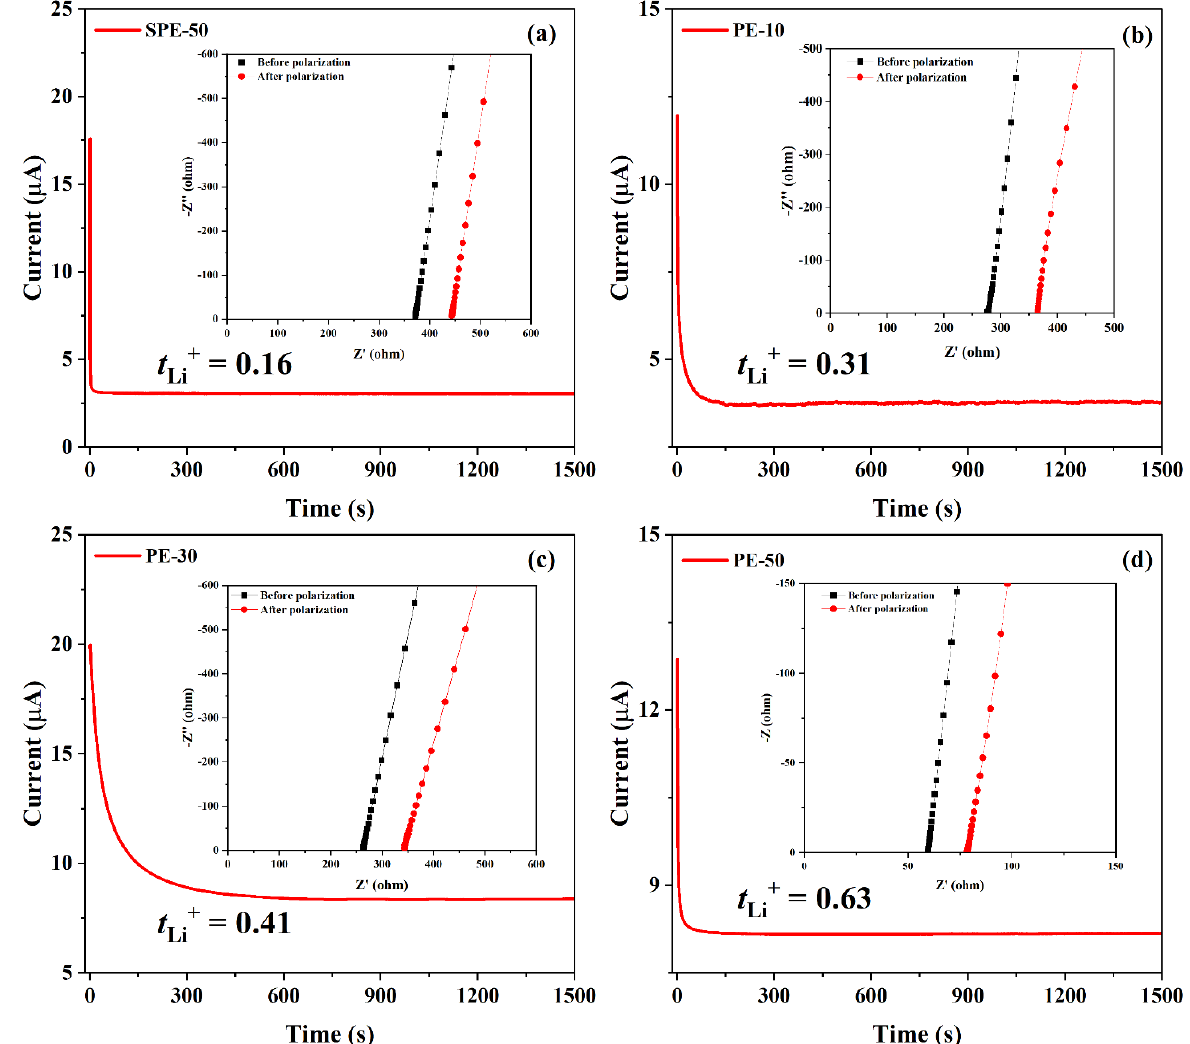
Figure 6. The chronoamperometry curve of the symmetrical cell Li/ PEs /Li at a polarization voltage of 10 mV. The inset shows the Nyquist plots of the cell before and after polarization for ( a ) SPE-50, ( b ) PE-10, ( c ) PE-30 and ( d ) PE-50, respectively, at RT. The electrolytes with 50 wt.% of LiFSI were used to further investigate cell perfor- mances because PE-50 showed the highest σ and t Li + in this work. These half-cells (LFP//PE50//Li, LFP-SPE50//Li and LFP-PE50//Li) were assembled and compared to fur- ther estimate the in situ polymerization and the DMF effect on the electrolyte in electro- chemical properties. Figure 7a describes a comparison of the first three cells’ cyclic volt- ammogram (CV) curves with a potential window from − 1 to 5 V (vs. Li/Li + ) at a scan rate of 1 mV s − 1 at RT. Lithium foil was applied as both the counter and reference electrodes and LFP was used as a working electrode. As shown in the figure, there is a small oxida- tion peak and no apparent reduction peak for the LFP//PE50//Li cell, indicating a coin cell with an inadequate redox system. In the case of LFP-SPE50//Li, the obvious redox peaks assigned to lithium plating and stripping are in a region of 0.25 and 3.5 V, but the cell still showed poor reversibility in the investigated range (Figure S5). On the contrary, the LFP- PE50//Li cell exhibits the anodic and cathodic peaks at 1.75 and 2.75 V and almost over- lapping CV curves, reflecting the promising cell electrochemical reversibility. To further study the particle application of fabricated PEs, a test of cell charging and discharging between 2.5 and 3.6 V (vs. Li/Li + ) at RT under 0.1 C was performed. The C rate was defined